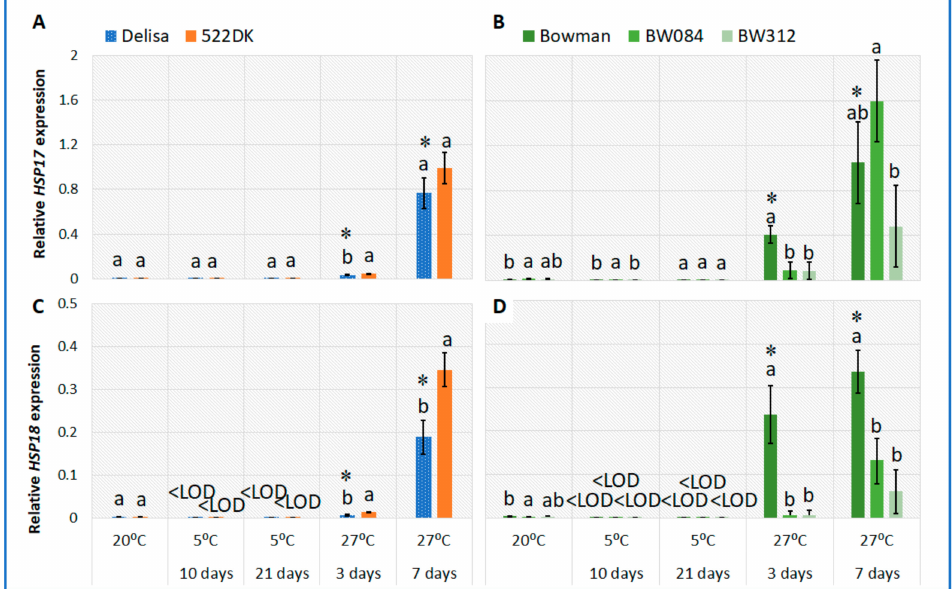
Figure 3. Relative transcript level of HSP17 and HSP18 in the barley leaves of the cv. Delisa, 522DK mutant ( A , C ), cv. Bowman, and the BW084 and BW312 ( B , D ) mutants at 20 ◦ C and during and after acclimation at 5 ◦ C and 27 ◦ C. The transcript levels are presented as the fold change in the expression of a specific gene in the specific samples compared to the reference gene actin . The statistical di ff erences between the cv. Delisa and its mutant 522DK (Student’s t -test, p ≤ 0.05) and between cv. Bowman and its mutants (Duncan’s test, p ≤ 0.05) for each temperature are indicated by di ff erent letters. Additionally, the accumulations of the transcript in the Delisa and Bowman cultivars at di ff erent temperatures were compared. The comparisons were performed in pairs (for 20 ◦ C and 5 ◦ C; 20 ◦ C and 27 ◦ C) (Student’s t -test, p ≤ 0.05) and the statistical di ff erences are indicated by an asterisk. LOD: below detection